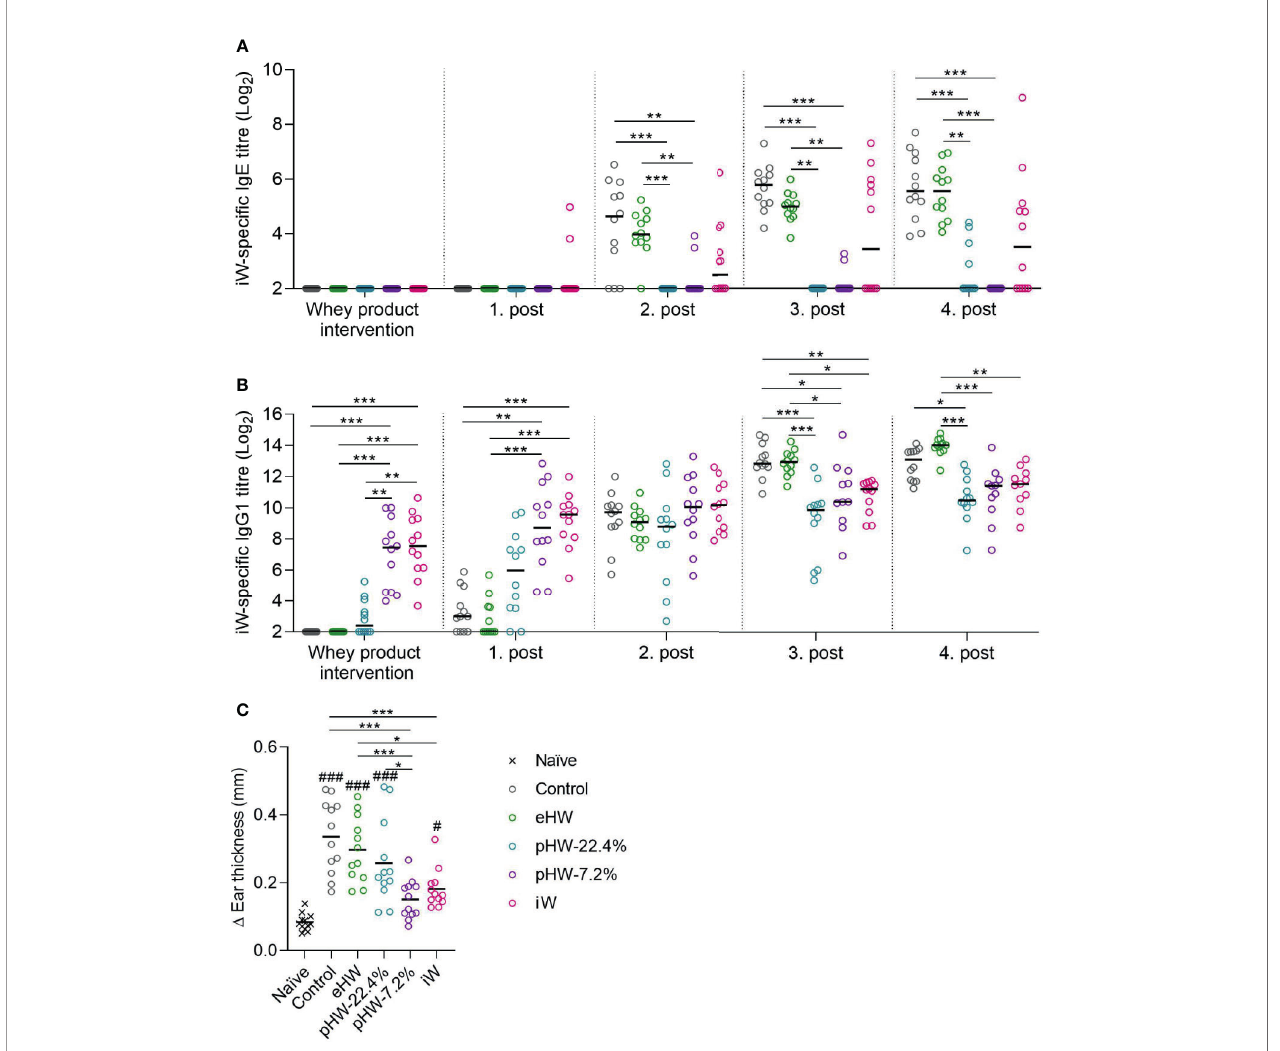
FIGURE 3 | Preventive capacity of the whey protein products. Intact whey (iW)-speci fi c IgE titres (A) , iW-speci fi c IgG1 titres (B) , and D ear swelling after ear-swelling test (C) in rats that received extensively (eHW), partially hydrolysed (pHW-22.4% or pHW-7.2%) or intact (iW) whey products in drinking water or water alone as control. Analyses were performed on sera after whey product interventions on Day 35 and after the post immunisations on Day 42, 49, 56 and 64. Each symbol represents a single rat and horizontal lines indicate median (A, B) or mean (C) values. Statistically signi fi cant differences between product groups are indicated as *p ≤ 0.05, **p ≤ 0.01, ***p ≤ 0.001, and between product groups and naïve controls as # p ≤ 0.05 and ### p ≤